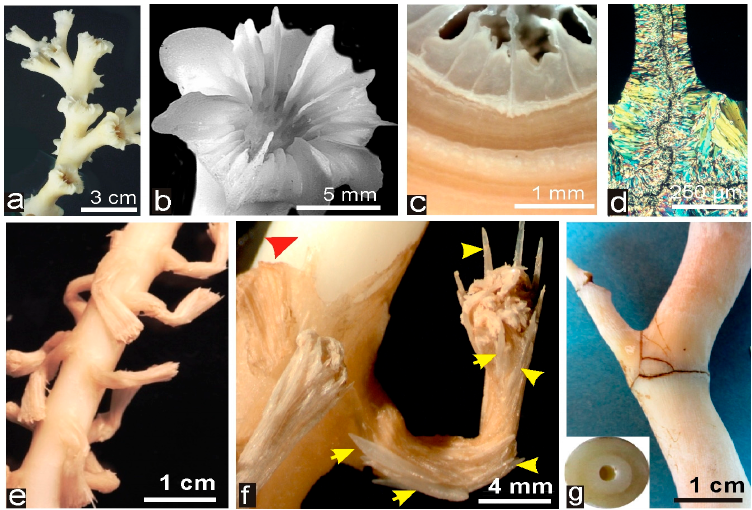
Figure 1. Deep-Sea Scleractinia corals (DSSC) and Deep-Sea Octocoralla Corals (DSOC). ( a – d ) Morphology and microstructure in one of the most studied DSSC: Lophelia pertusa. Dendroid colonies ( a ) are built by simple corallites ( b ) with radial linear septa and thick walls ( c – e ). Thin sections of septa exhibit typical crystal-like fibers perpendicular to the median continuous area). ( e ) Axis and polyps in one of the studied DSOC specimen (cf. Acanella sp., Muséum National d’Histoire Naturelle-MNHN-collections, Paris); ( f ) red arrow indicates the solid axis (normally covered by the common tissues joining the polyps) and yellow arrows point to the calcareous spicules that form the dense but flexible skeleton of the polyps; and ( g ) view of the articulated solid axis and the studied section (named Terrasses from the place it was collected).